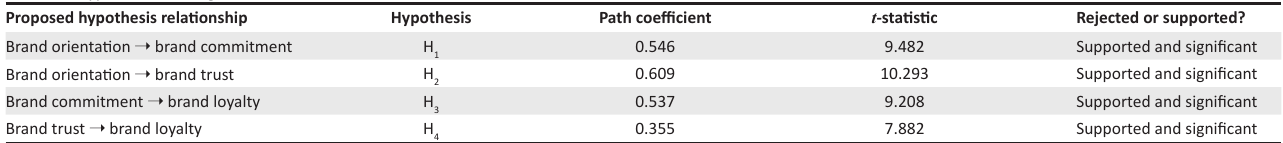
FIGURE 2: Path model. Similar to the CFA model, the circles symbolise the latent variables while the rectangles symbolise the observed variables. The unidirectional pointer signifies the impact of one variable on TABLE 4: Hypothesis testing results.